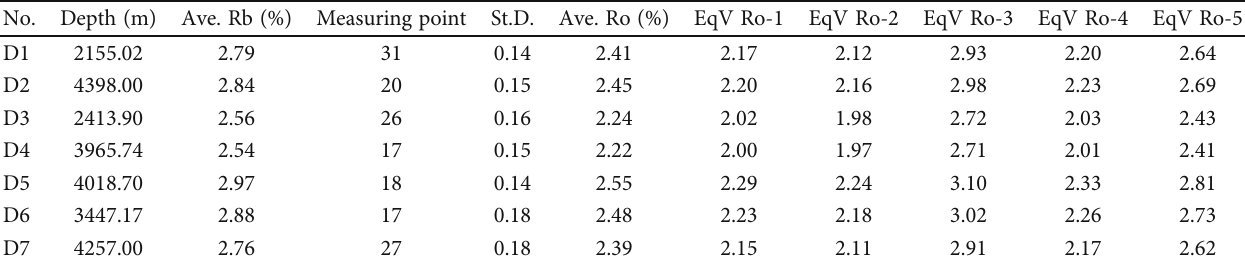
Figure 3: Random re fl ectance distribution of solid bitumen in di ff erent samples. Table 2: Solid bitumen random re fl ectance and equivalent vitrinite re fl ectance in seven